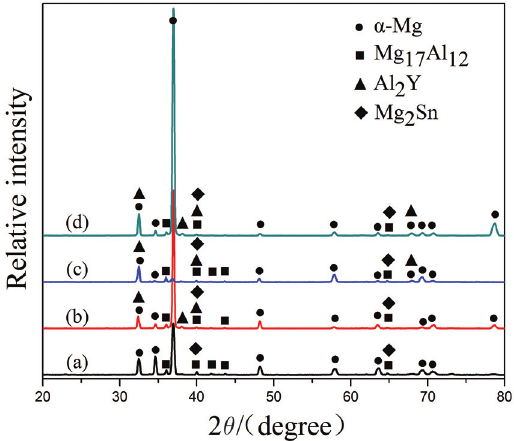
Figure 1: The XRD patterns of the as-cast AZ80 – 2Sn alloys with different Y additions: (a) alloy 1; (b) alloy 2; (c) alloy 3; (d) alloy